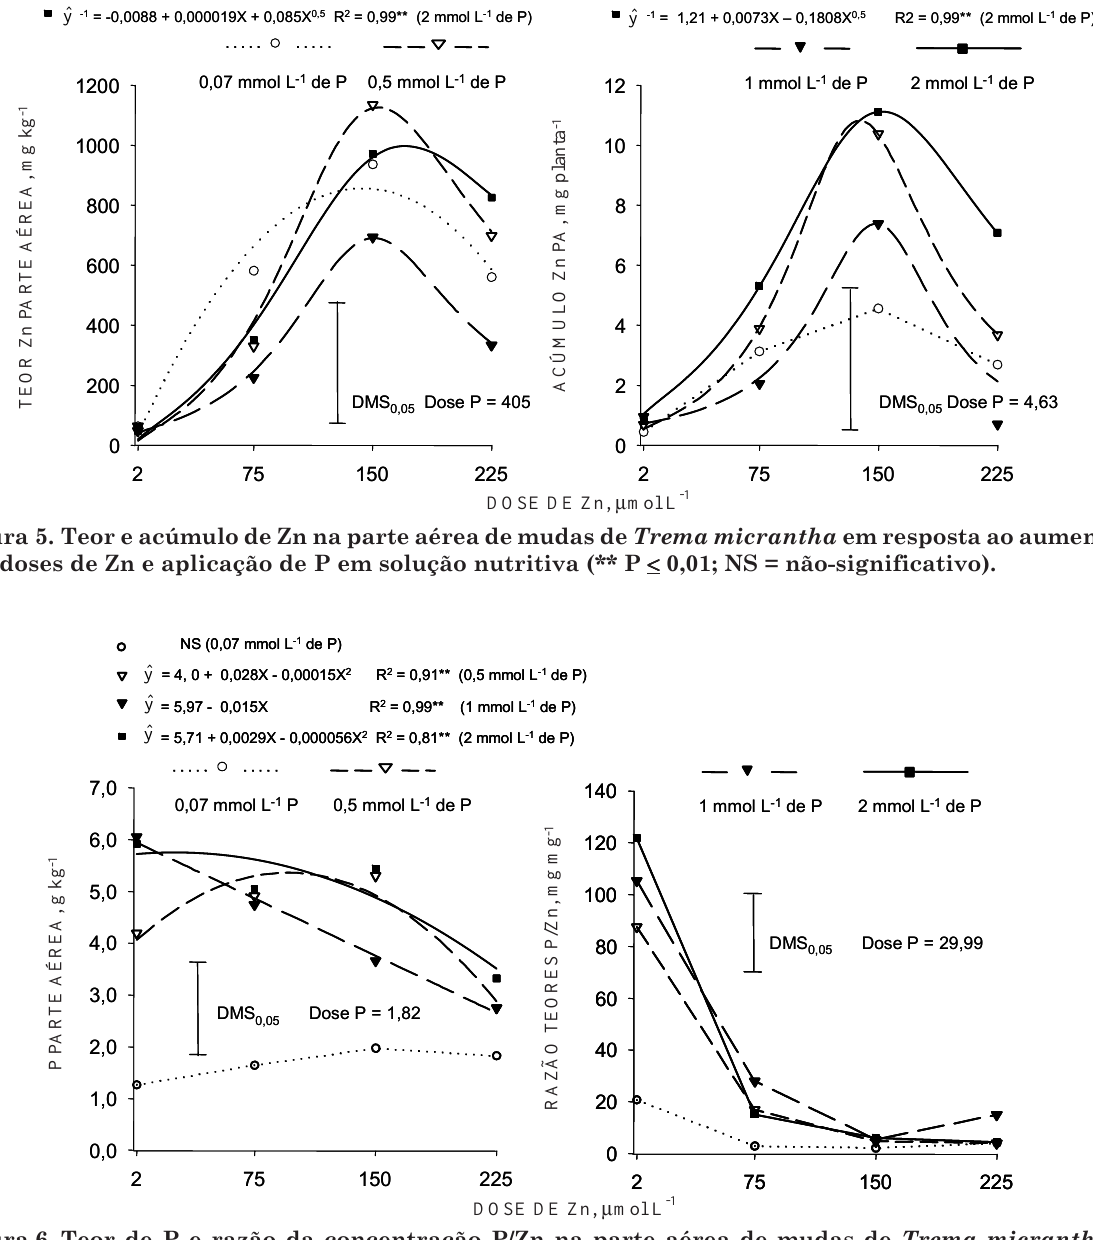
Figura 6. Teor de P e razão da concentração P/Zn na parte aérea de mudas de Trema micrantha em resposta ao aumento de doses de Zn e aplicação de P em solução nutritiva (** P <<<<< 0,01; * P <<<<< 0,05; NS =